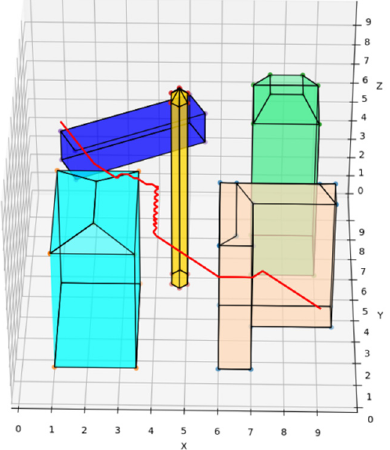
Figure 15. UAV route with light load and mild disturbance.